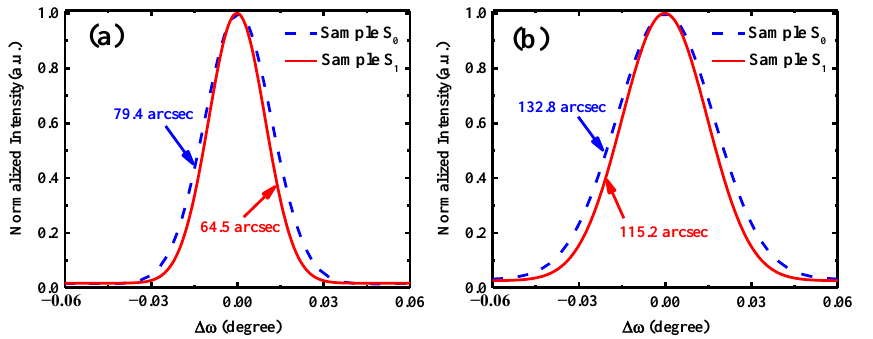
Figure 3. The XRCs of both samples measured in ( a ) symmetric (002) and ( b ) asymmetric (102) reflection.